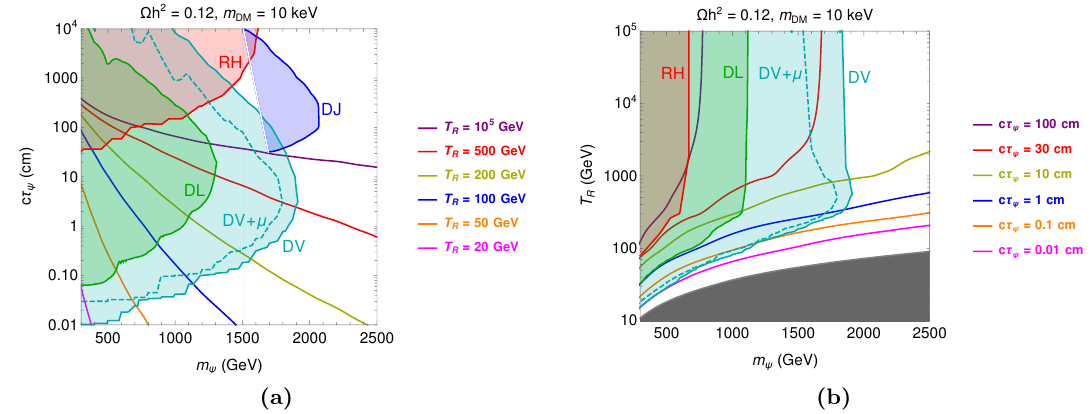
Figure 10. Tophilic DM with m χ = 10 keV. Contours for fixed value of T R account for the DM relic abundance in the ( m ) plane (left), and contours of fixed cτ do the same in the ( m ) ψ , cτ ψ ψ ψ , T R plane (right). The value of T associated to a given ( m ) provides an upper bound on T for R ψ , cτ ψ R any dark matter mass as m & 10 keV due to small scale structures constraints. The blue shaded χ area is excluded by the DV+MET search, the red area by R-hadron searches, the blue dashed area by DV+ µ search, the dark blue area by the DJ search, and the green area by the DL search.